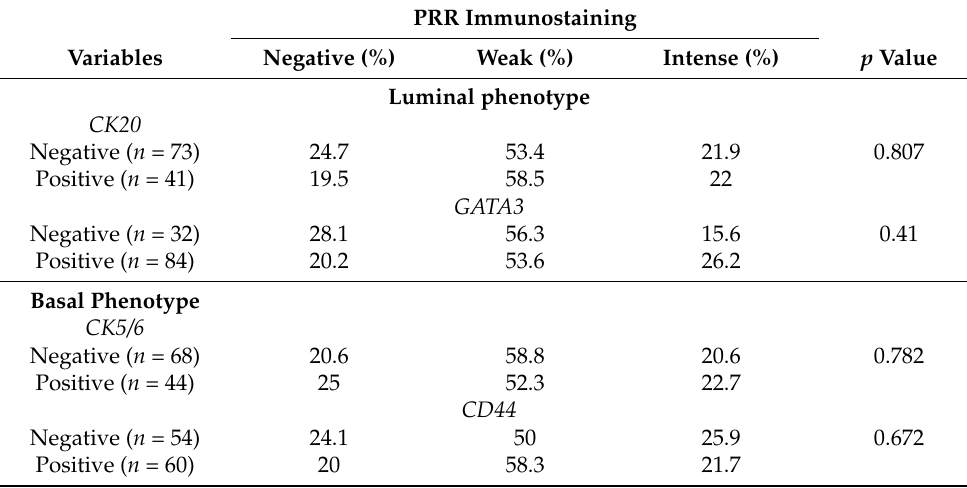
Table 3. Association between PRR expression and other immunohistochemical